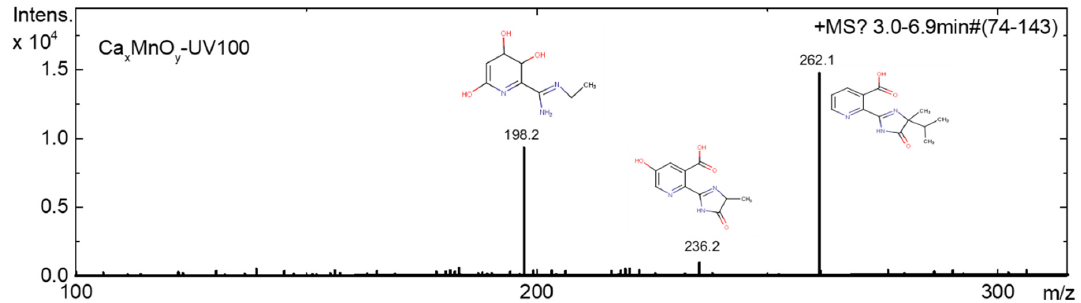
Figure 17. MS (positive and negative) mode of products generated after 300 min of irradiation using Ca x MnO y -TiO 2 .